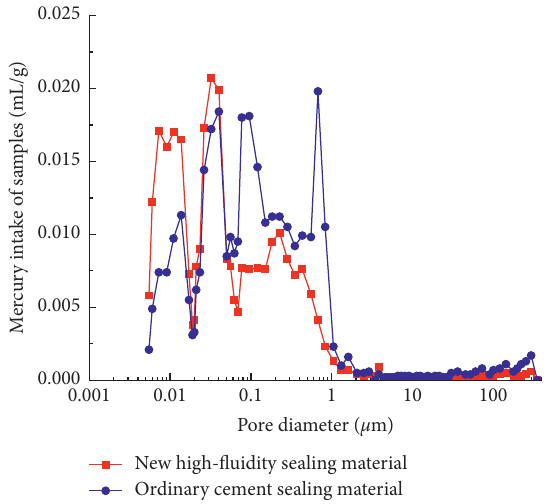
Figure 9: Distribution curves of pores of different sizes in two